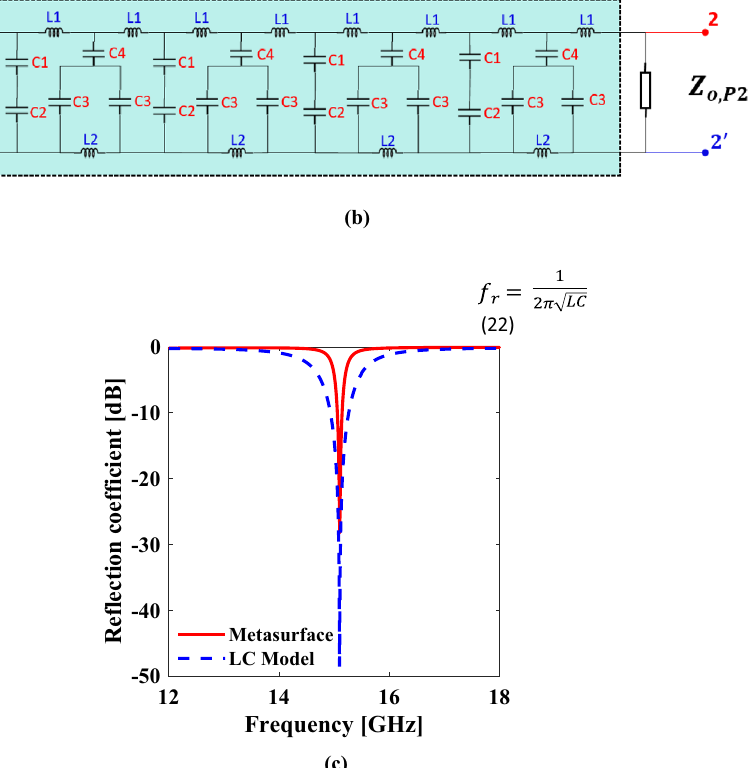
Figure 3. ( a ) Metasurface impedance model ( b ) Equivalent LC Circuit ( c ) Comparison of resonance achieved by LC model with metasurface. *The ( a ) and ( b ) are create using Microsoft Power Point-Office 365-URL: https:// www. office. com/ power point; while the ( c ) is created using MATLAB ver. R2020A-URL: https:// www. mathw orks. com/ produ cts/ matlab.